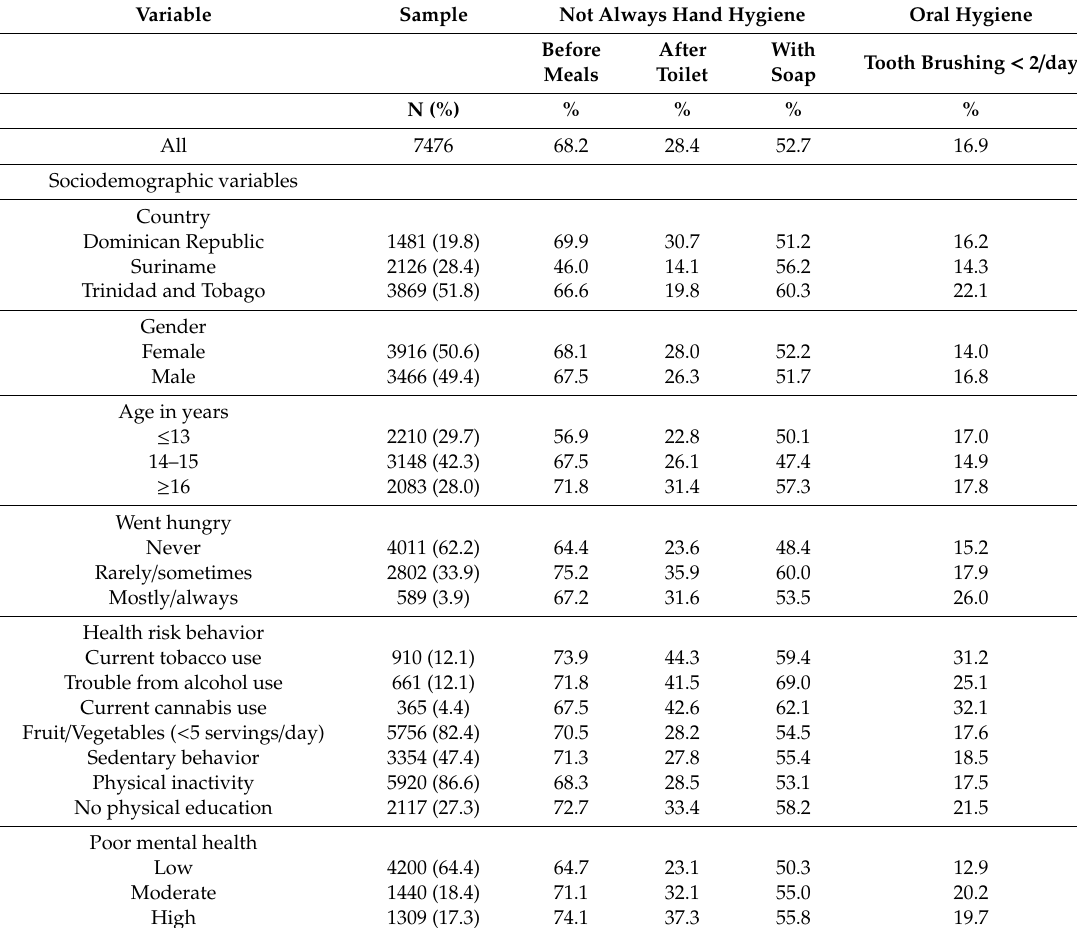
Table 1. Characteristics of the sample and hygiene behavior in the Dominican Republic, Suriname, and Trinidad and Tobago, 2016–2017. Variable